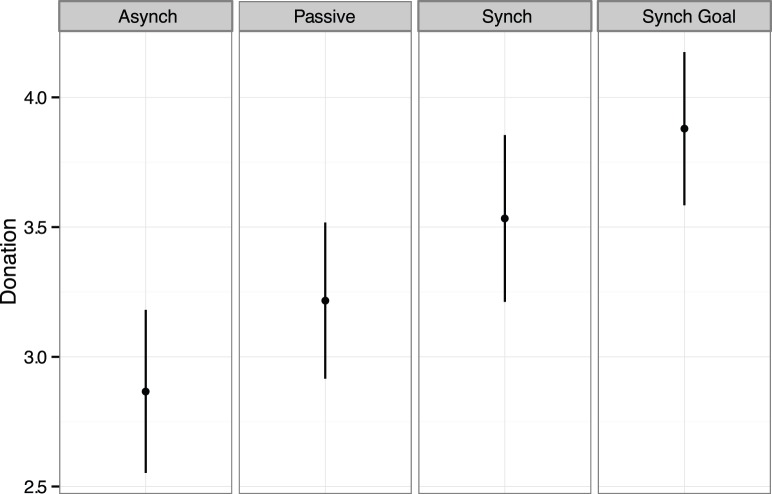
Cooperation across experimental conditions for Experiment 1.Each dot represents the mean amount of money donated to the group investment (dollars). Error bars are +/− SE.